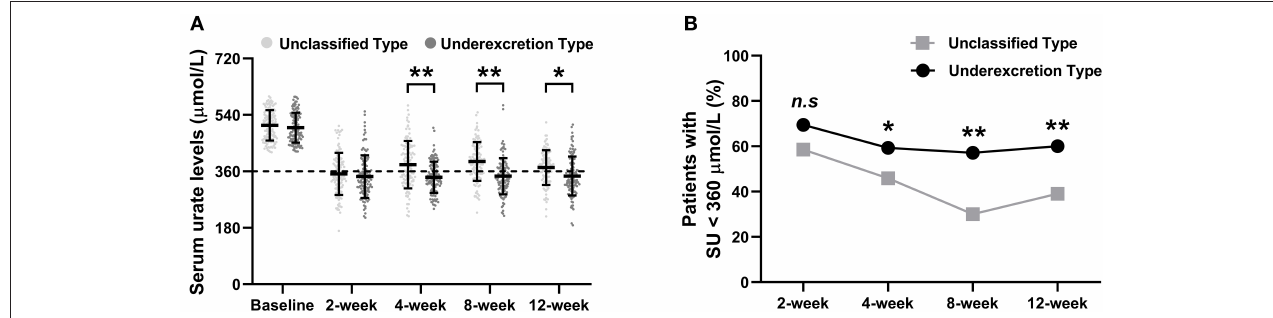
FIGURE 2 | The primary outcomes of the urate-lowering therapy based on hyperuricemia classification. (A) The trend of serum urate level and (B) proportion of patients with SU < 360 µ mol/L during the 12-week study. SU levels are presented as the mean ( ± SD). Rates are expressed as proportions. SU, serum urate. Symbols * and ** indicate P < 0.05 and < 0.01 between the unclassified and underexcretion groups, respectively.